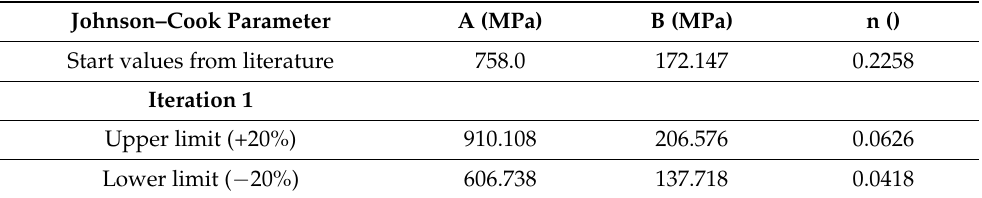
Table 4. Parameter Range Limits for The First Identification Iteration Regarding Start Parameters from The Literature.